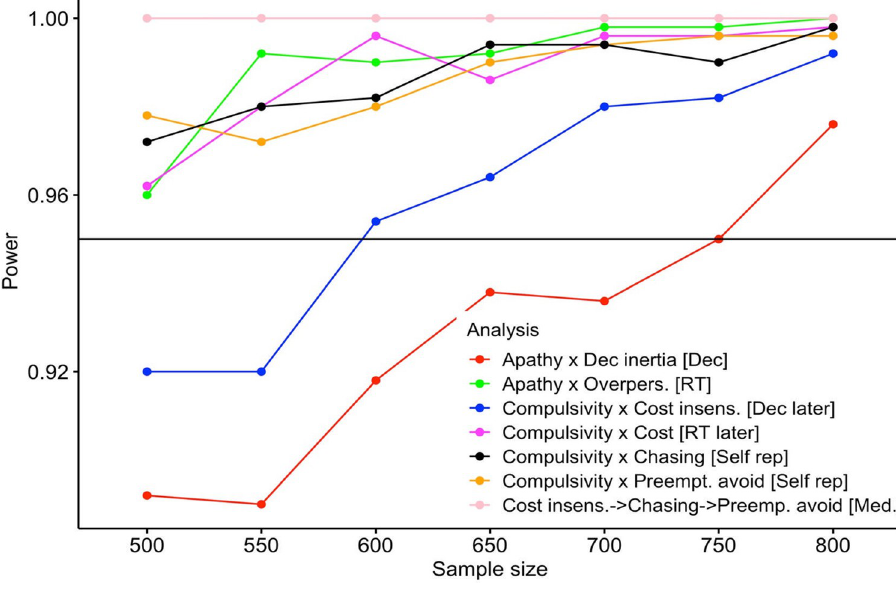
Fig 6. Power analysis. Power increases with sample size. To reach 95% power in the analysis with lowest power (i.e., analysis of the impact of apathy on overperseverance measured in the participants’ decisions), we selected 750 participants for the confirmation sample. n RT, reaction